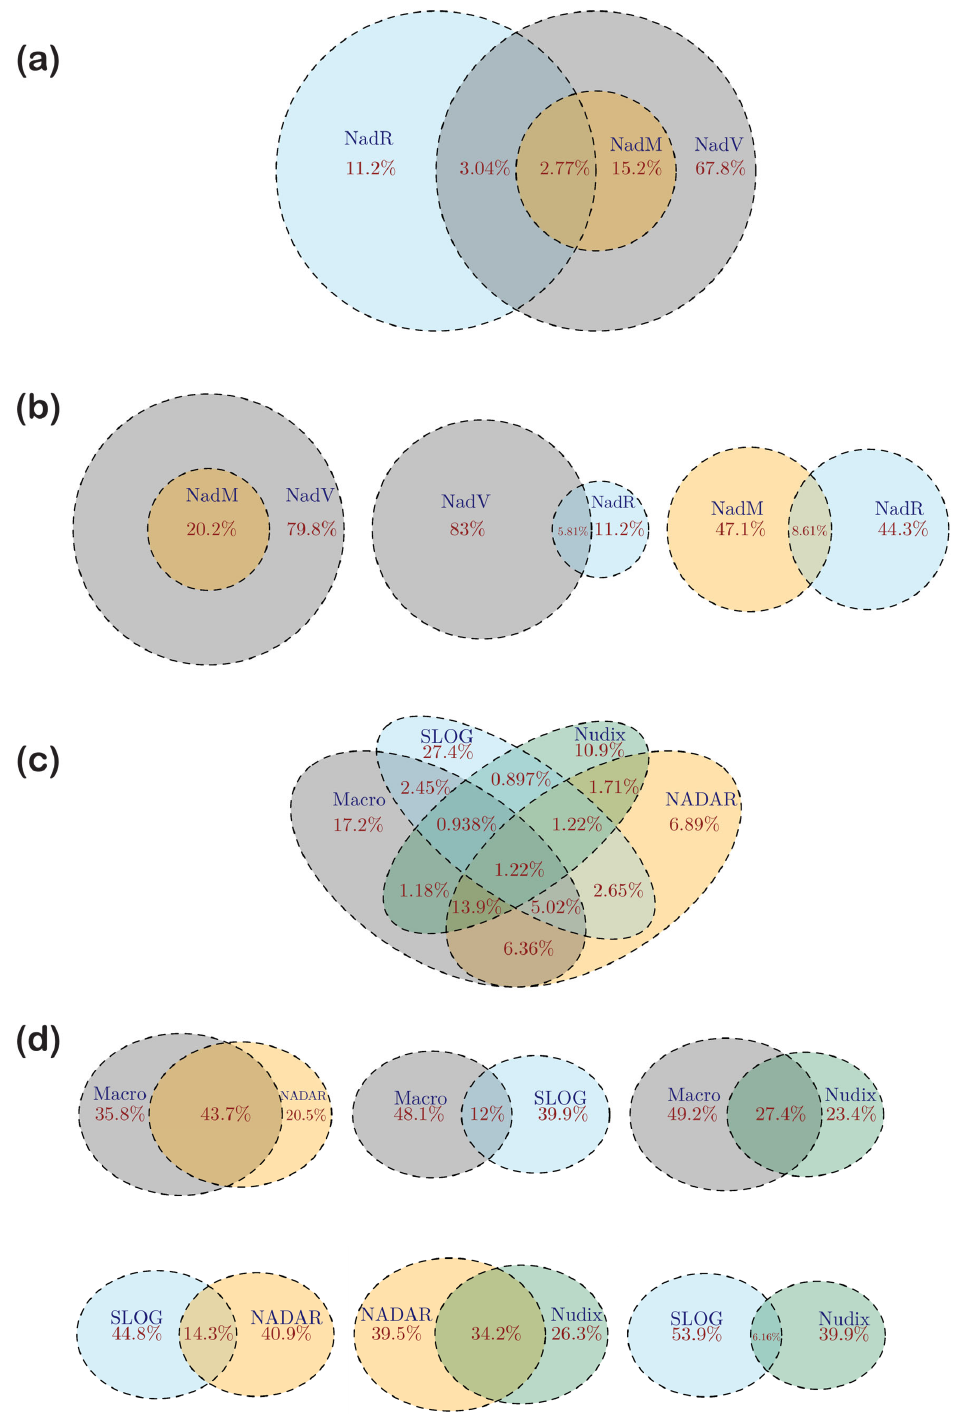
Figure 6. Complete and pairwise co-occurrence patterns of NAD + –ADPr domains depicted as Euler diagrams. ( a , b ) Domains involved in NAD + biosynthesis/salvage in viruses. ( c , d ) Co-occurrence of the Macro, SLOG, Nudix and NADAR domains in DNA viruses. Co-occurrences are measured as a percentage of all the proteins that are being compared in a particular Euler